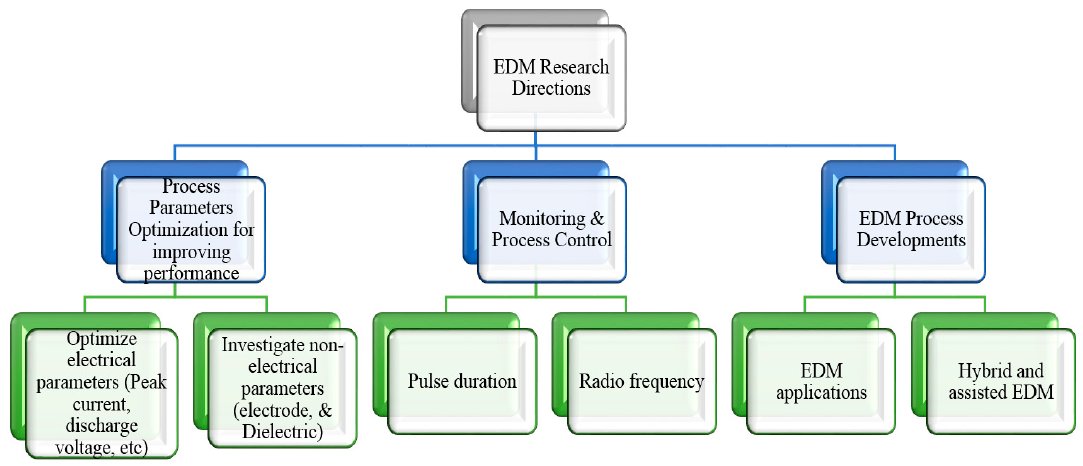
Figure 18. Classification of research directions.